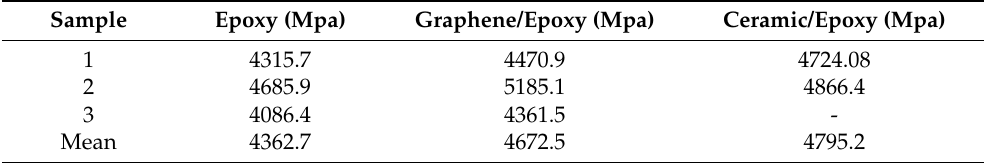
Table 1. Young’s Modulus Values of Epoxy and Nanocomposites.